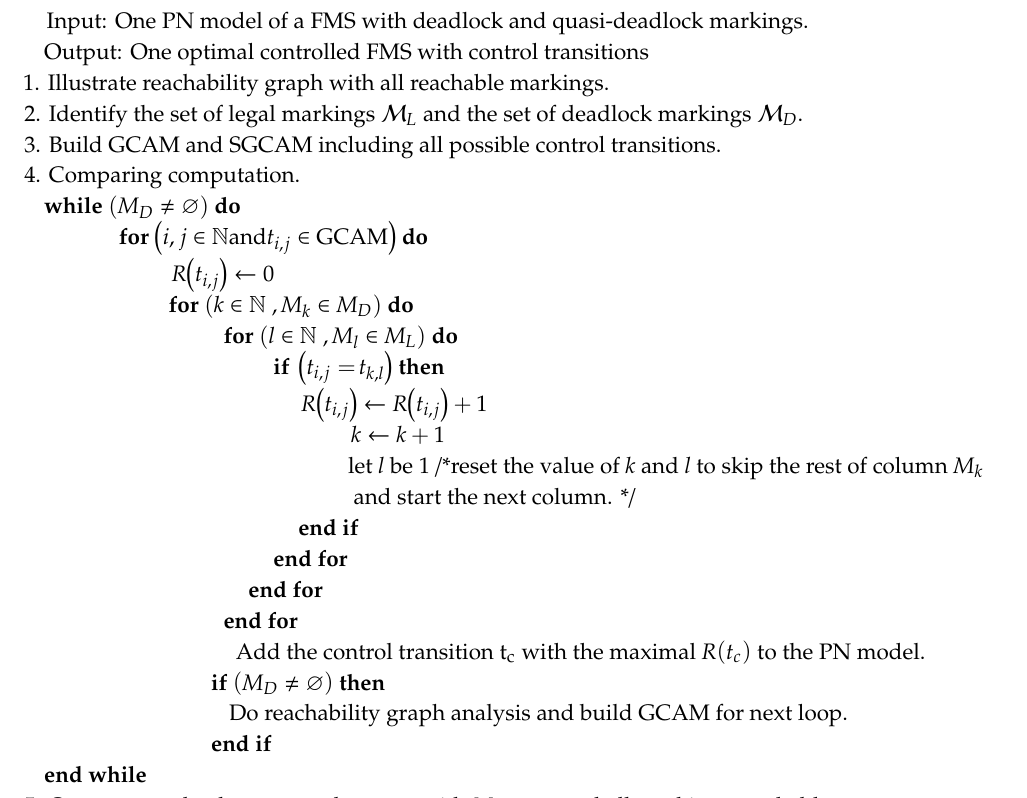
Algorithm 1: GCAM-based Recovery Control Transition